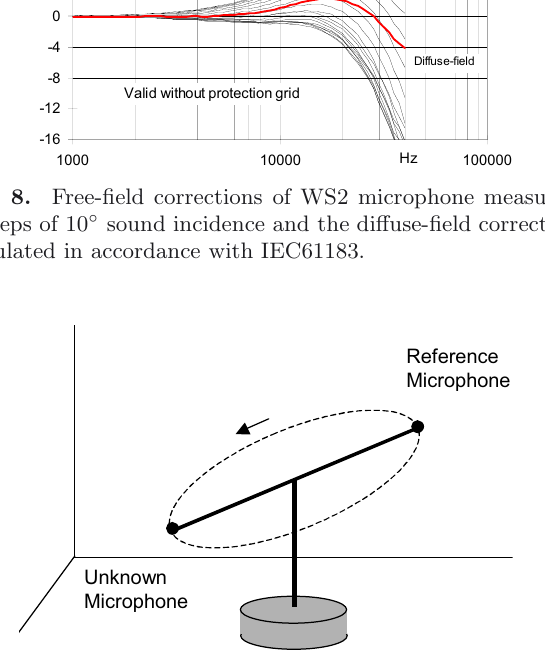
Fig. 9. Diffuse-field calibration by comparing a large unknown microphone with a reference microphone that is several times smaller. By moving the microphones in the room the possible effects of dominant standing waves at specific frequencies is